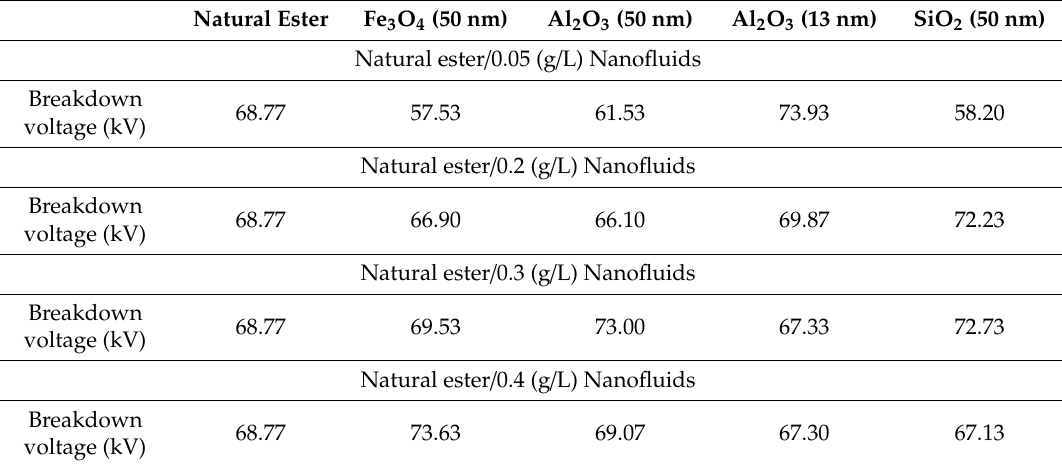
Table 4. Mean value of AC-BDV of di ff erent natural ester (MIDEL 1204)-based nanofluids [112].